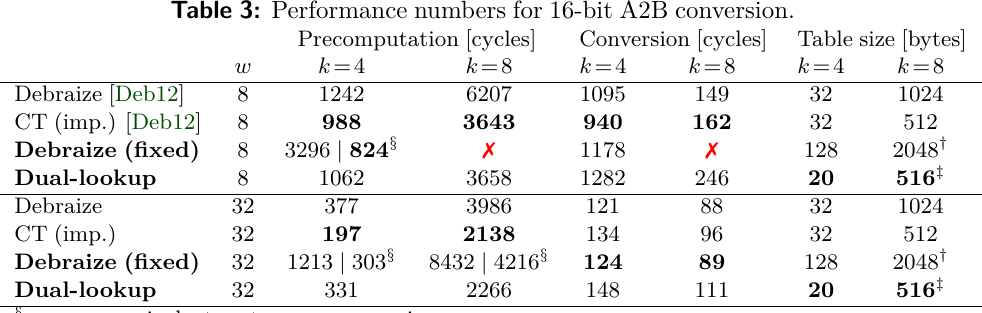
Table 3: Performance numbers for 16-bit A2B